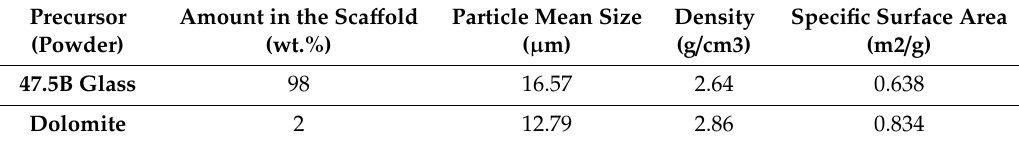
Table 1. Summary of physical properties of precursors used for the production of the